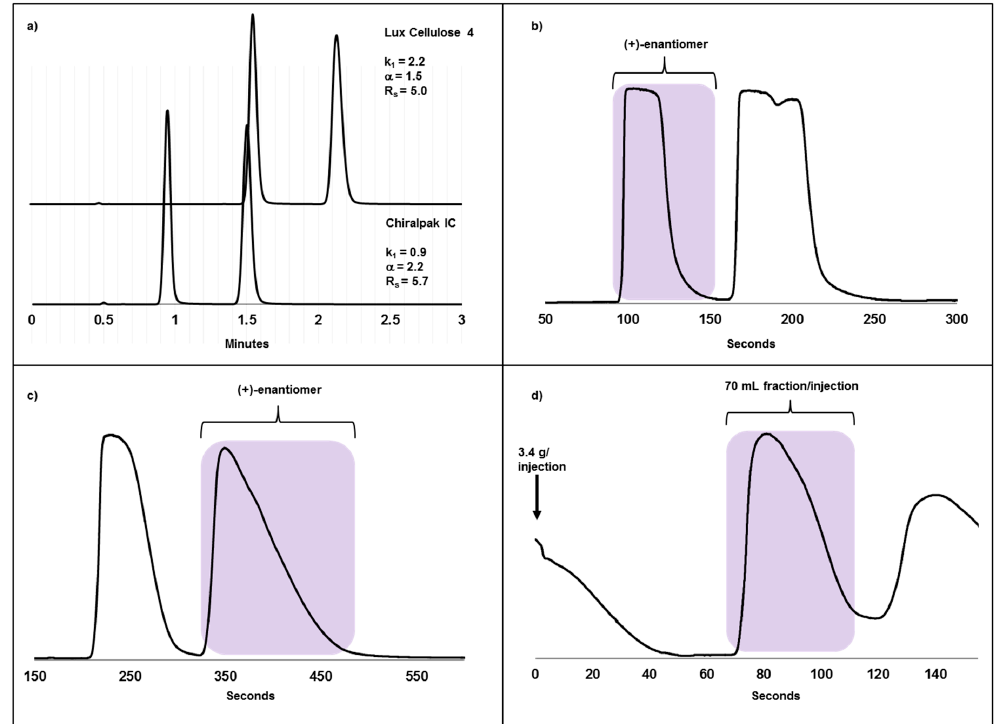
Figure 2. Chiral separation of compound B , a racemic carboxylic acid. ( a ) Analytical